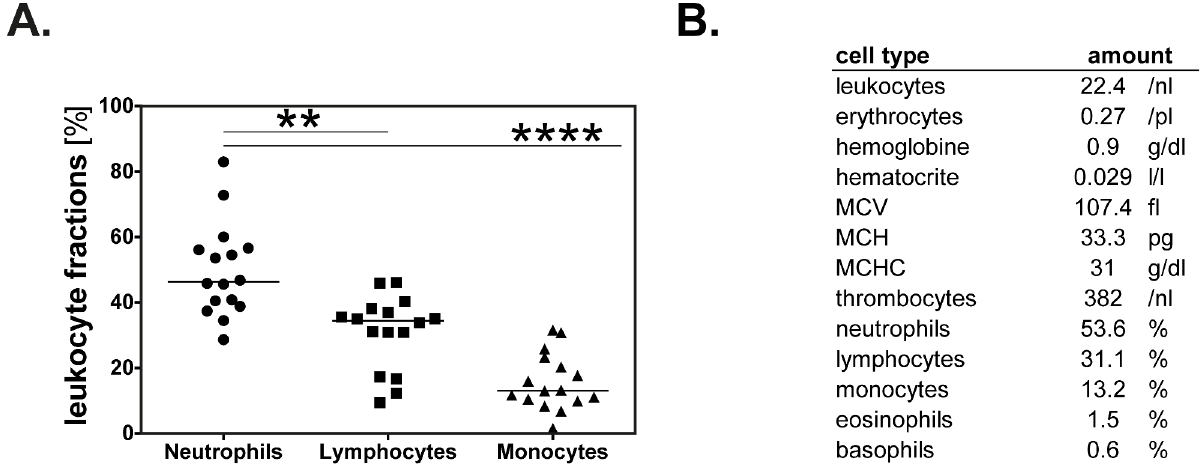
Fig 1. Neutrophils account for the majority of cells treated during ECP. (A) Percentages of neutrophils, lymphocytes and monocytes of total leukocytes in buffy coats of 16 patients with chronic GVHD (cGVHD) taken from Therakos UVAR XTS ECP- device immediately after chemoirradiation prior to reinfusion. Lines show means; scatters represent individual patients. ** p (cid:3) 0.01, **** p (cid:3) 0.0001. (B) Representative composition of a buffy coat of one patient with cGVHD.